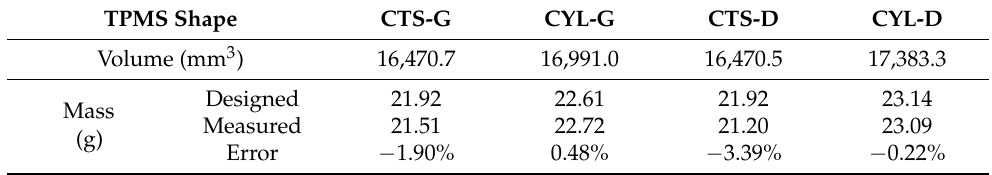
Table 4. Comparison for the mass of various TPMS shapes (volume fraction: 50%).